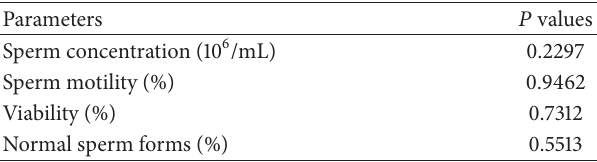
Table 1: Summary statistics of semen parameters and OS